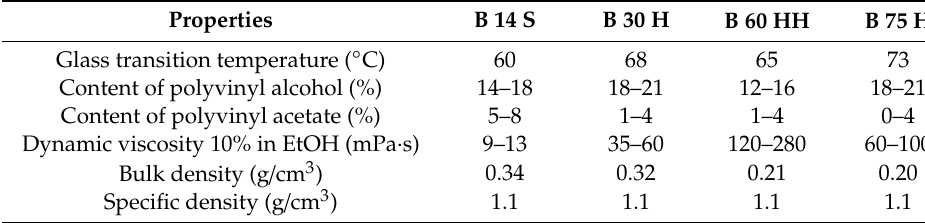
Table 2. Properties of common types of Mowital ® powder [28].